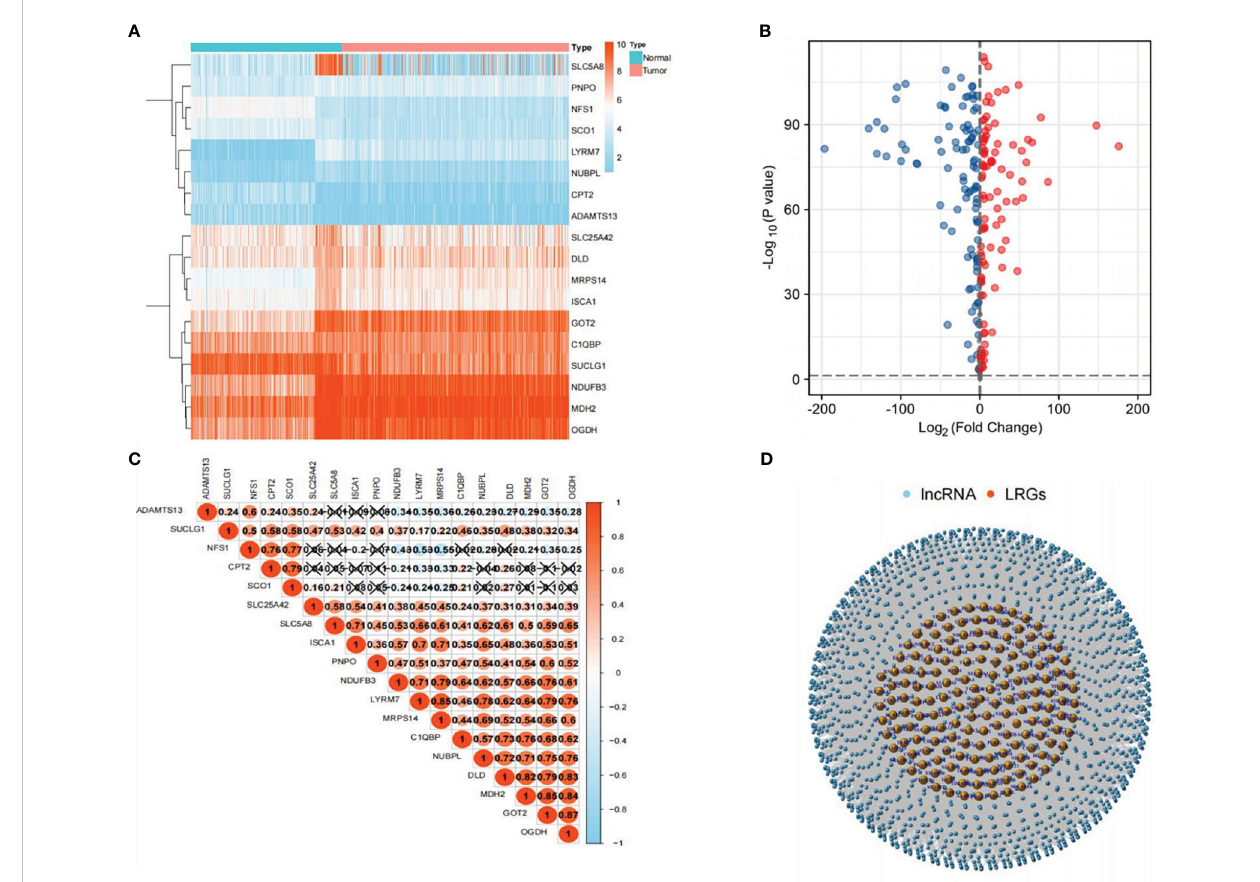
FIGURE 2 Selection of LRLs. (A) Heat map showing the differential expression of 18 genes related to lactate metabolism in tumor and normal groups. (B) Distribution of all genes in the tumor and normal groups: the red bubble is log 2 FC>1, and the blue bubble is log 2 FC<-1. The p-value for both red and blue distributed genes was less than 0.001. (C) Correlation between 18 LRGs, the darker the color, the stronger the correlation. (D) Distribution of LRLs associated with LRGs (cor>0.4,